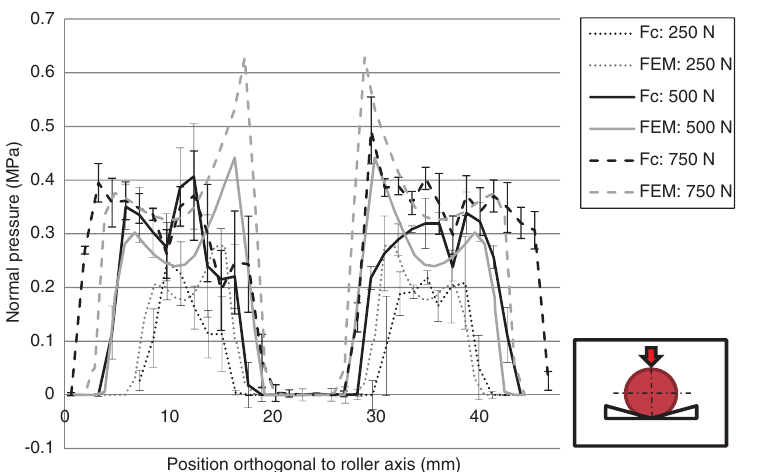
Figure 25 Normal pressure of the compaction roller in longitudinal direction orthogonal to roller axis on the concave tool.